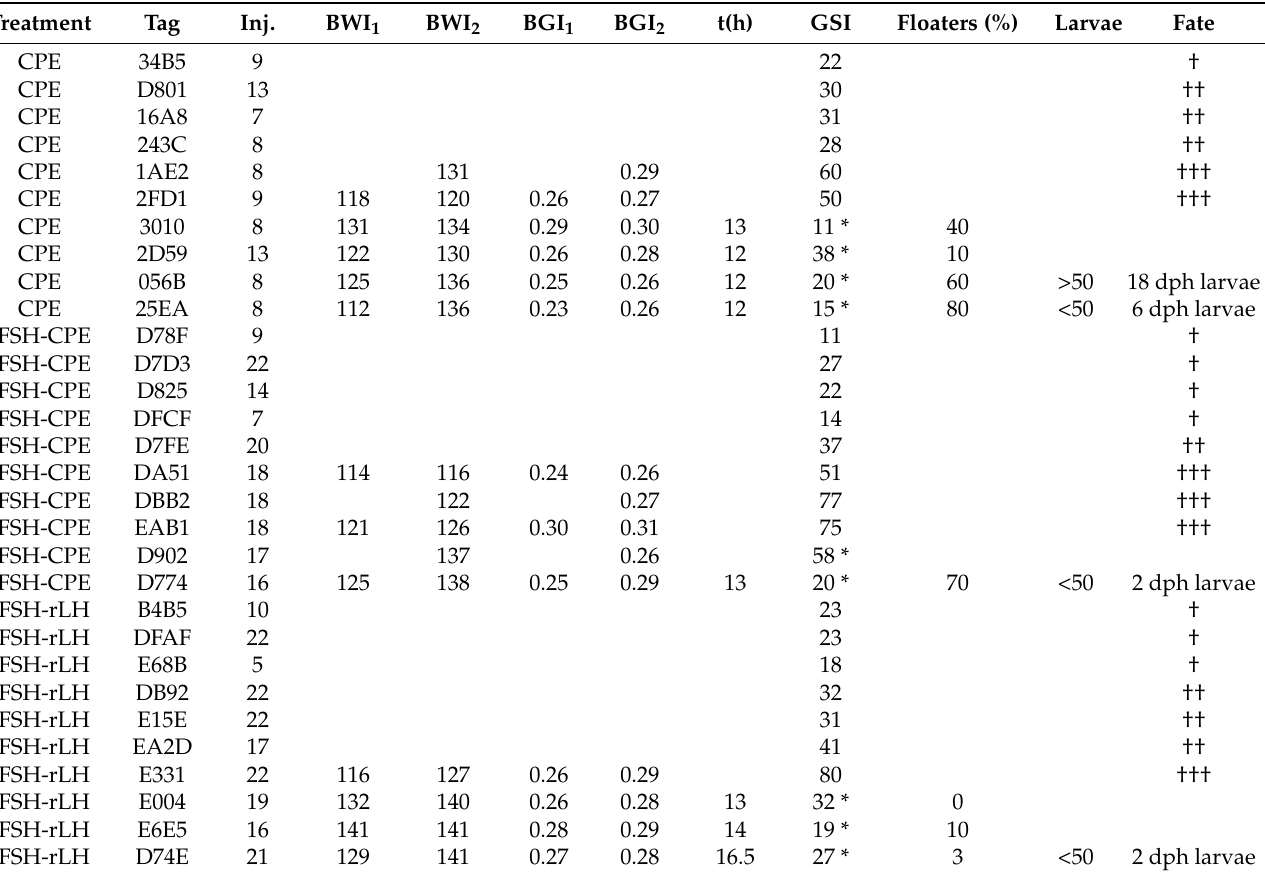
Table 3. Reproductive success of the three treatment groups (CPE, rFSH-CPE and rFSH-rLH). Tag, PIT-tag code; Inj., number of weekly injections to reach maturation; BWI 1 , BWI at booster moment; BWI 2 , BWI at DHP injection; BGI 1 , BGI at booster moment; BGI 2 , BGI at DHP injection; t(h), hours after DHP injection; GSI, gonadosomatic index of females that died before/during maturation; Floaters, percentage of floaters after 1 h fertilization; Larvae, number of larvae after hatching; Fate, fate of the